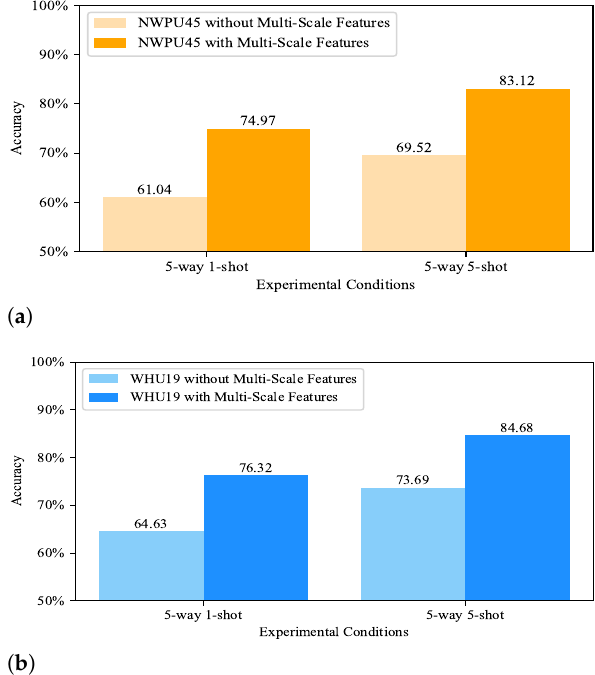
Figure 7. Comparisons of different scales of features on two datasets. ( a ) shows the test results on the NWPU-RESISC45 dataset with different scales of features, ( b ) shows the test results on the WHU-RS19 dataset with different scales of